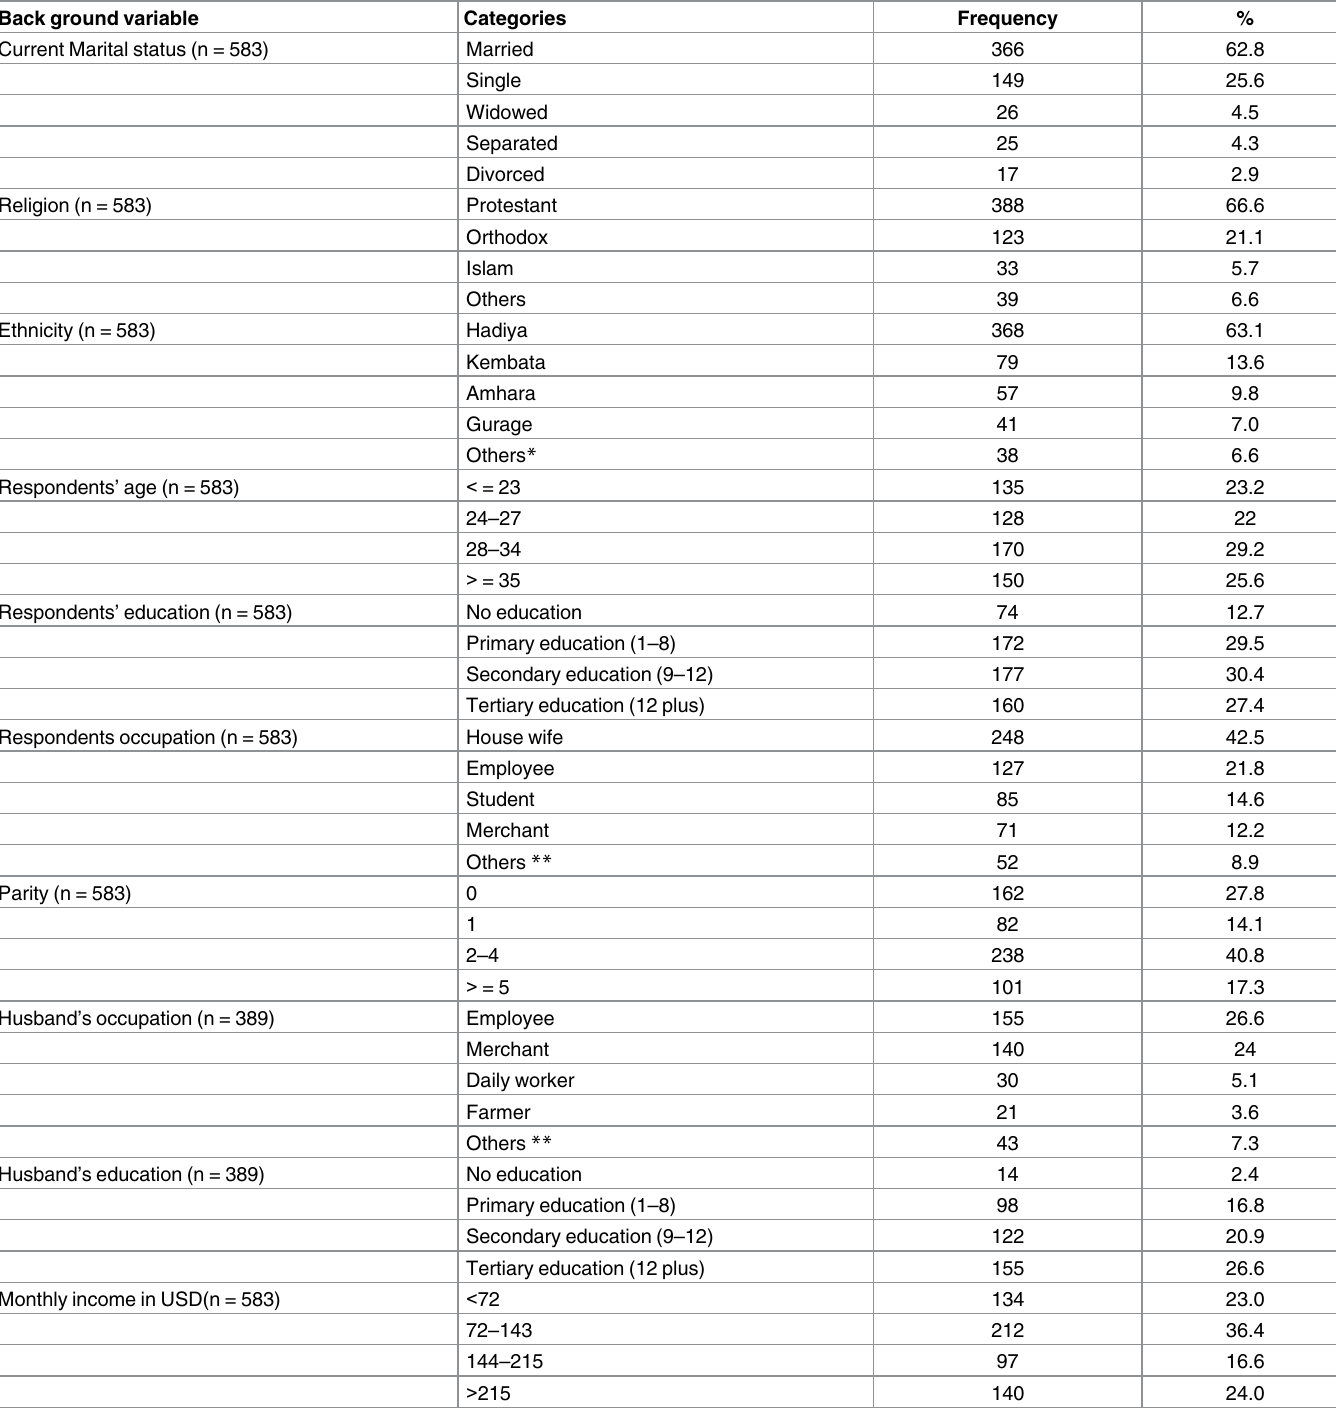
Table 1. Socio-demographic characteristics of respondents of health seeking behavior in Hossana town Hadiya Zone, Ethiopia, June